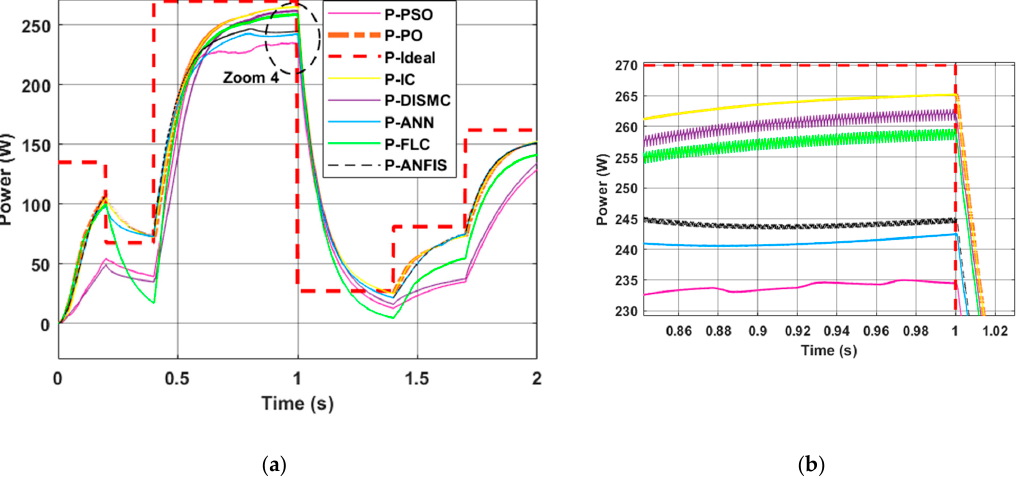
Figure 18. ( a ) Evolution of power; ( b ) Zoom 4 of power curves: Scenario 2 of Test 2.